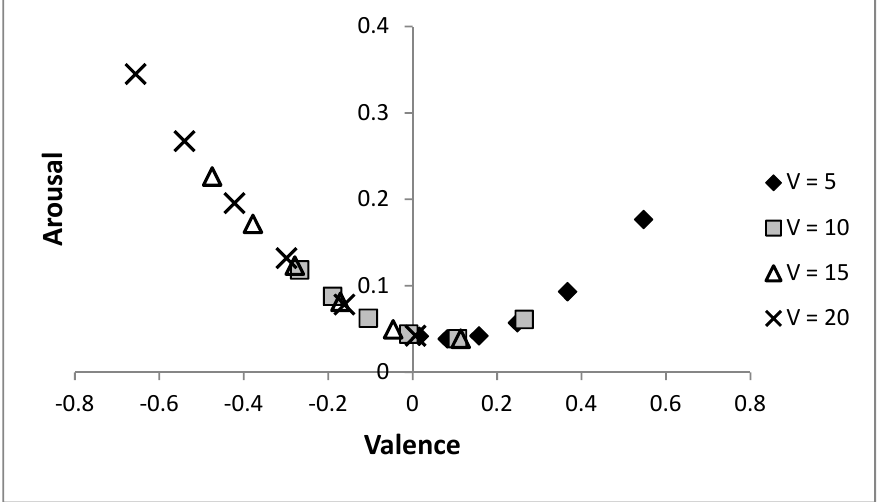
Figure 8. Altering the value of life and the risk of predation can produce the same moods